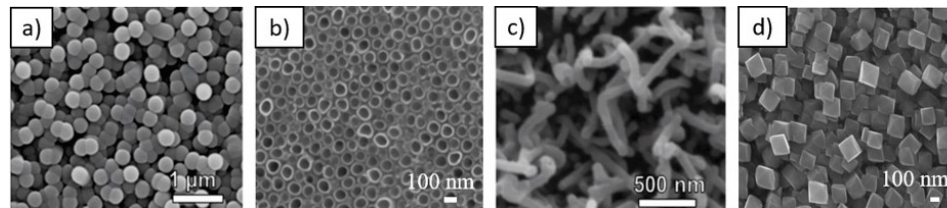
Figure 3. TiO 2 nanostructured surfaces: ( a ) microbeads, ( b ) nanotubes, ( c ) nanowires and ( d ) octahedral nanoparticles. Partially reprinted ( a , c ) by permission from Springer Nature: Springer Protoplasma [51] (2016).